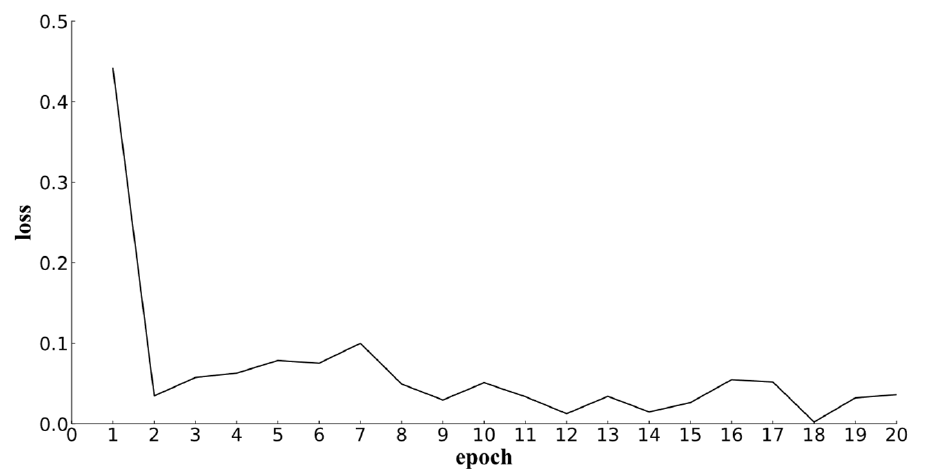
Figure 13. Loss Figure 13. Loss curve.